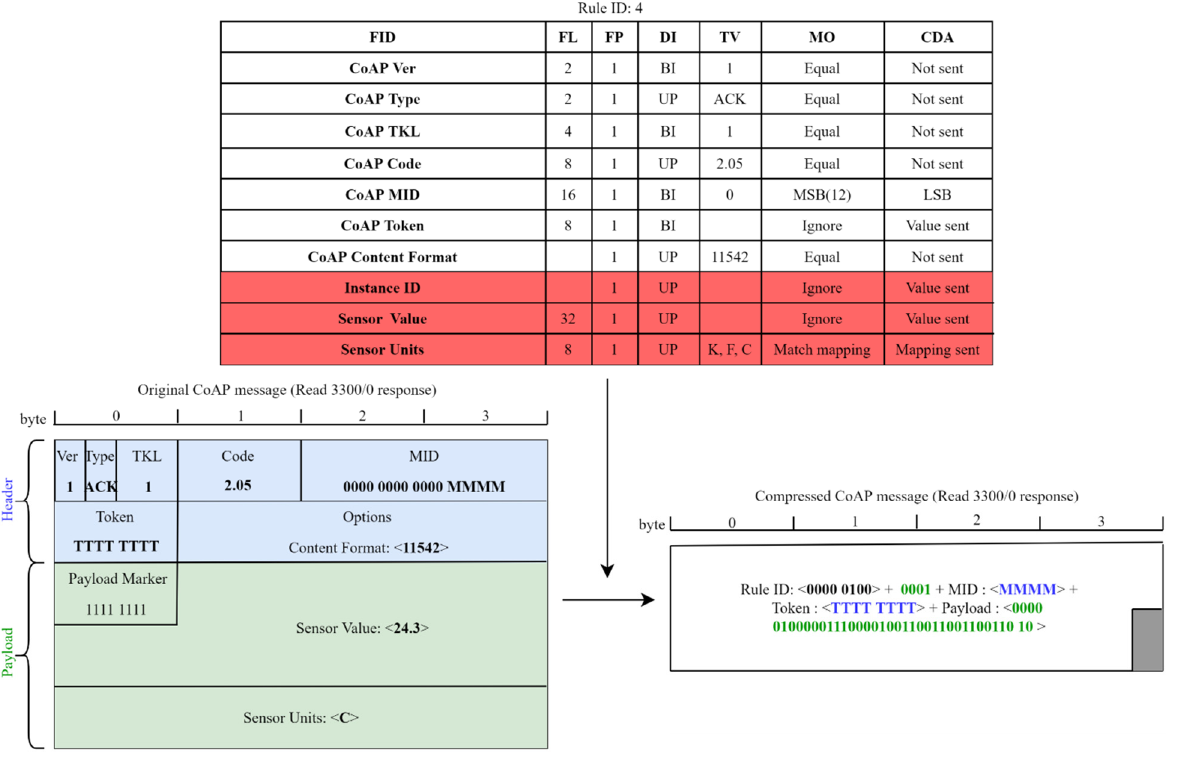
Figure 12. Extended SCHC used in LoRaWAN.